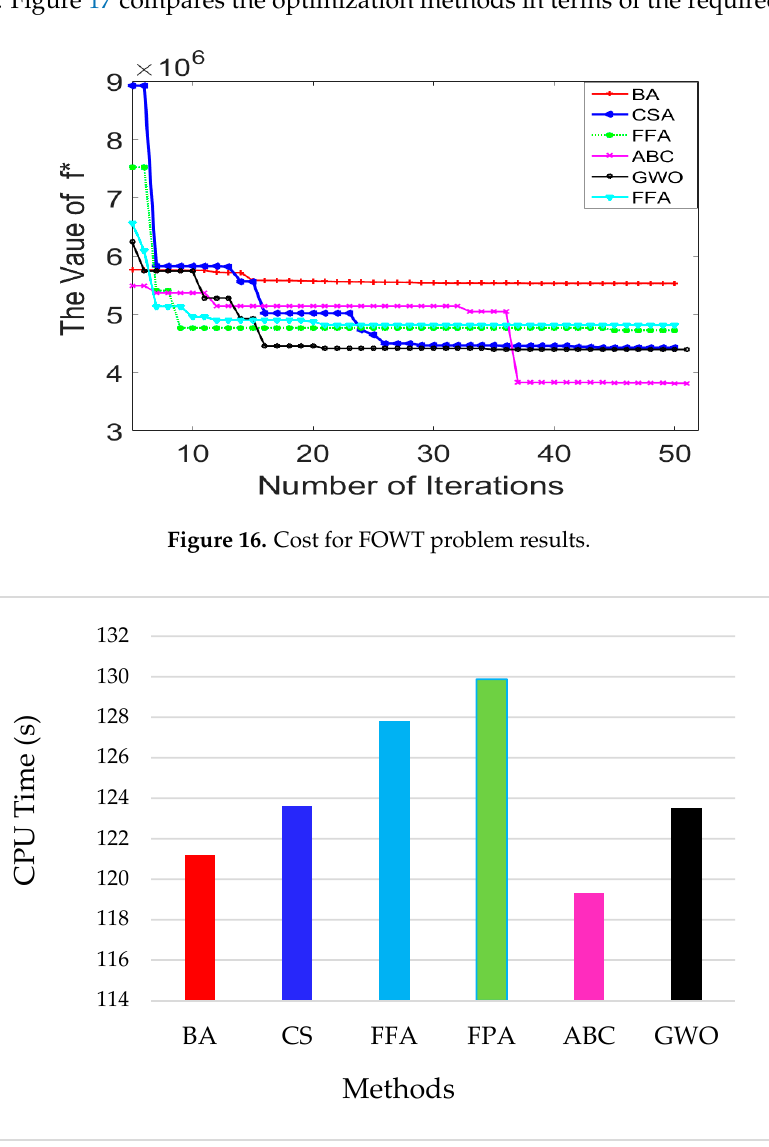
Figure 17. Required CPU time for FOWT problem.